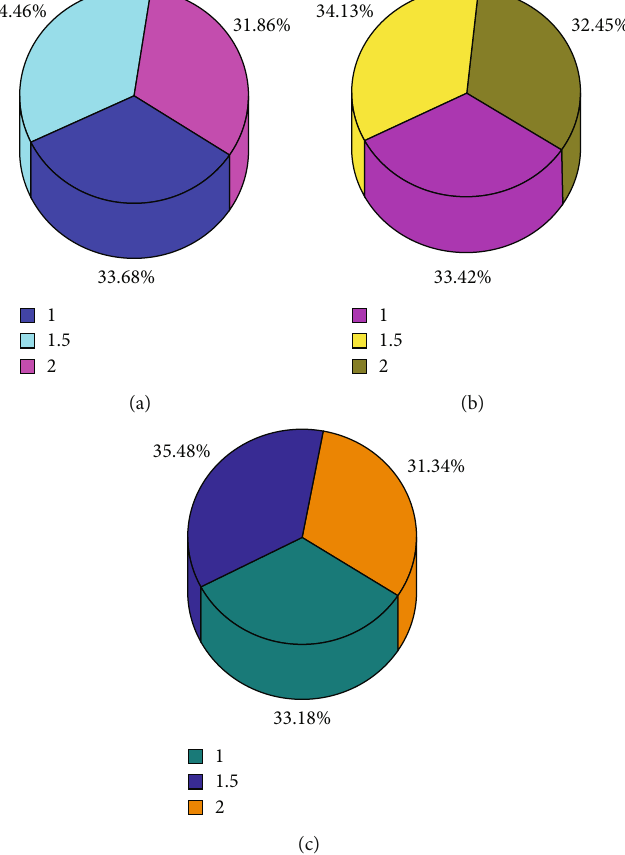
Figure 5: Nanosilica contributions of mechanical properties: (a) tensile; (b) fl exural; (c) impact